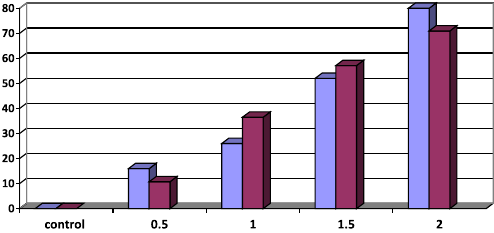
Fig. 1. Susceptibility of 2 nd Larval Instar of M. domestica Vicina to Different Concentration of Bacillus thruingiensis isralensis After 48hrs of